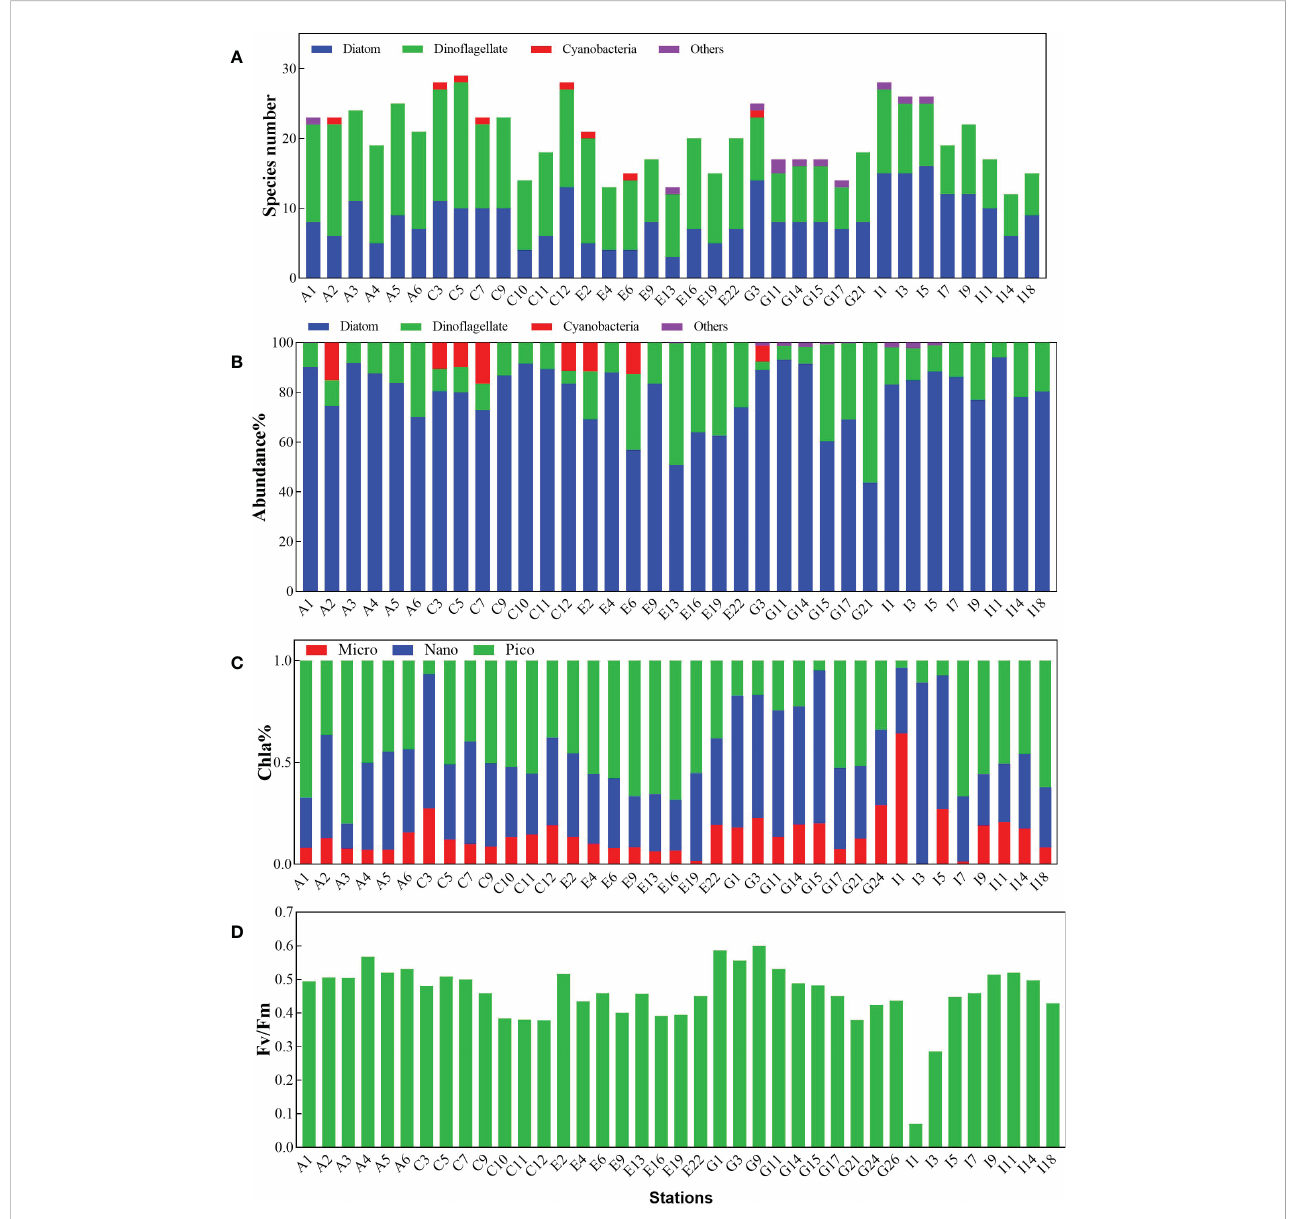
FIGURE 4 Relative characteristics of phytoplankton community in different sampling sites. (A) species numbers distributed in different phytoplankton groups. (B) the abundance of different phytoplankton groups. (C) size-fractionated chlorophyll a concentration. (D) the maximum quantum yield of PS II ( F v /F m ). Others represent species belonging to Chrysophyceae and